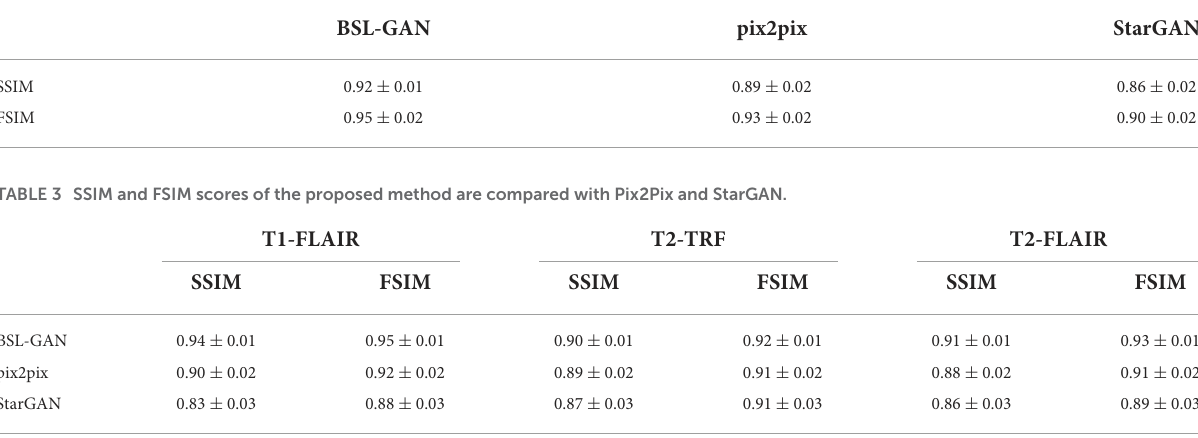
TABLE 2 Comparison of self-monitoring constraint performance under different models: Comparison of scores between single-branch input and multi-branch input in task method with auxiliary network.